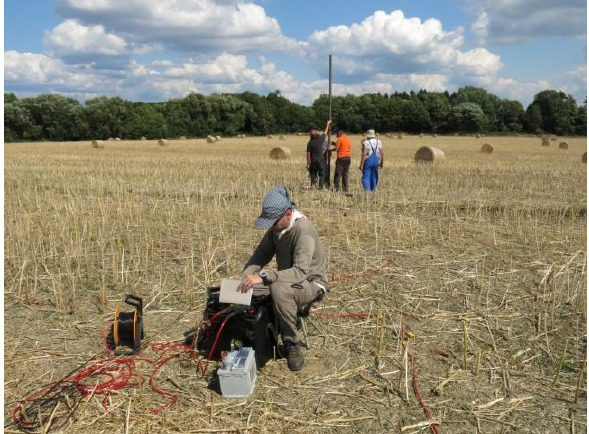
Figure 18. The seismic measurement in a field. In the front is seismic equipment, in background is seismic resource (impact mechanism).